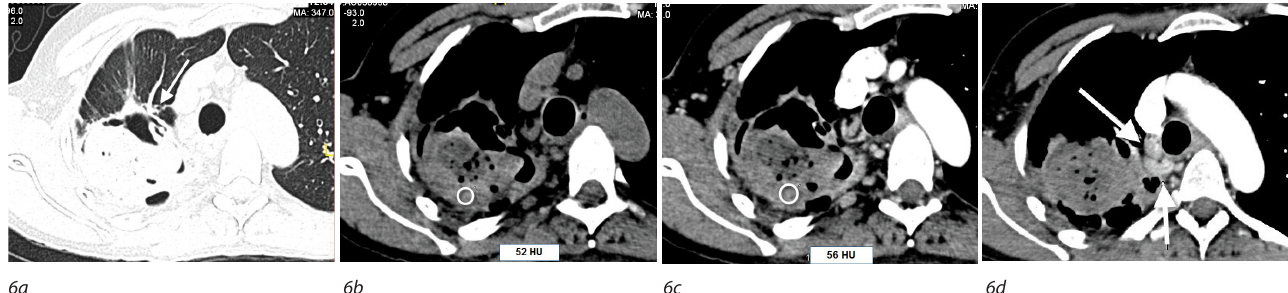
6a 6b 6c 6d Fig. 6. A lung mass showing increased density of 52HU on the precontrast scan (6b) with no significant enhancement on the 60 s post-contrast scan (6c). There are inflammatory uniformly enhancing lymph nodes in the adjacent mediastinum – arrow in 6d.